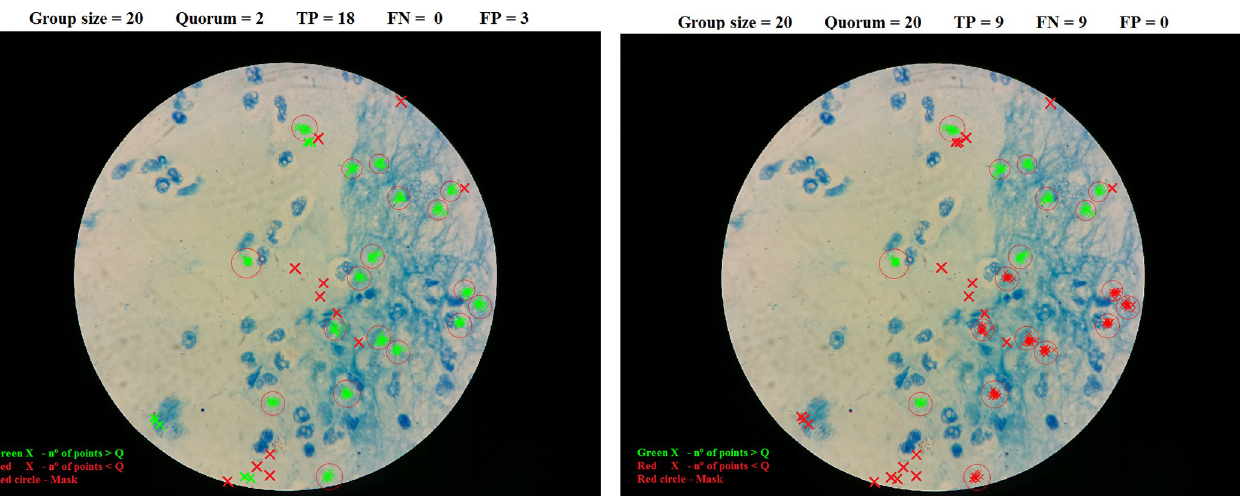
PLOS ONE | https://doi.org/10.1371/journal.pone.0268494 May 19,